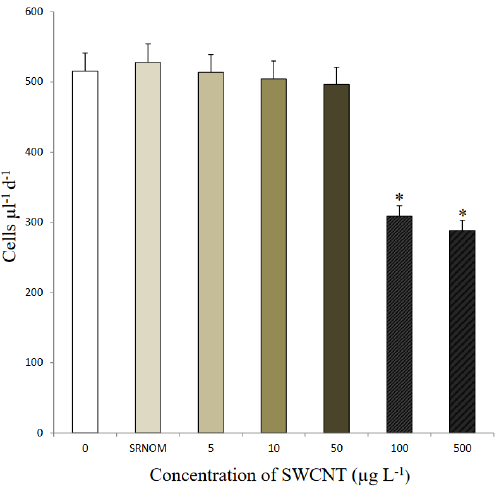
Figure 7. Tetraselmis suecica growth rate during exposure to SWCNTs prepared in 0.02% SRNOM at nominal concentrations (5 µ g L − 1 , 10 µ g L − 1 , 50 µ g L − 1 , 100 µ g L − 1 , and 500 µ g L − 1 ). Statistically, there was no significant difference between SRNOM, 5 µ g L − 1 , 10 µ g L − 1 , 50 µ g L − 1 and control groups; (*) significant growth inhibition occurred >100 µ g L − 1 (One Way ANOVA: F = 1.82 df num = 5, means ± SD; n = 3; p < 0.001).